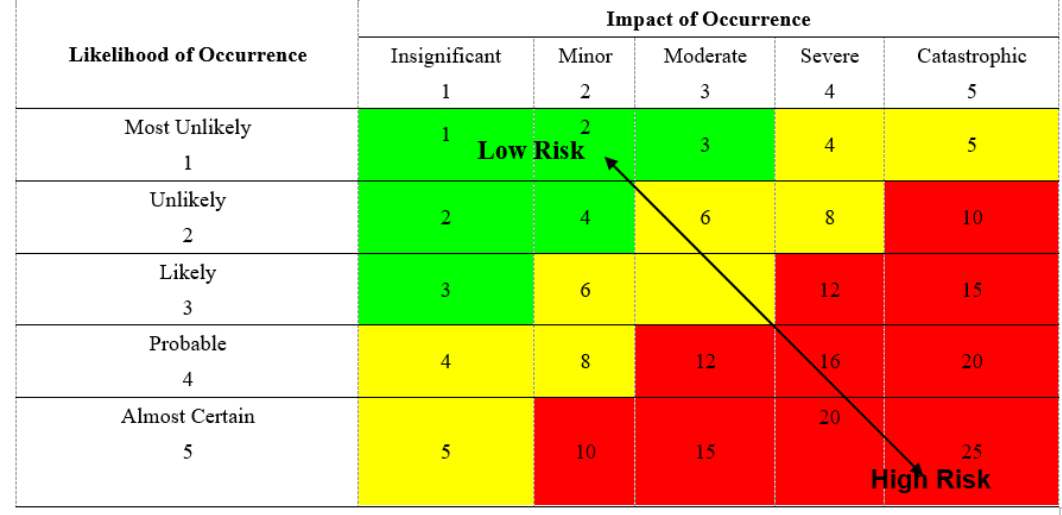
Figure 3. Risk matrix.